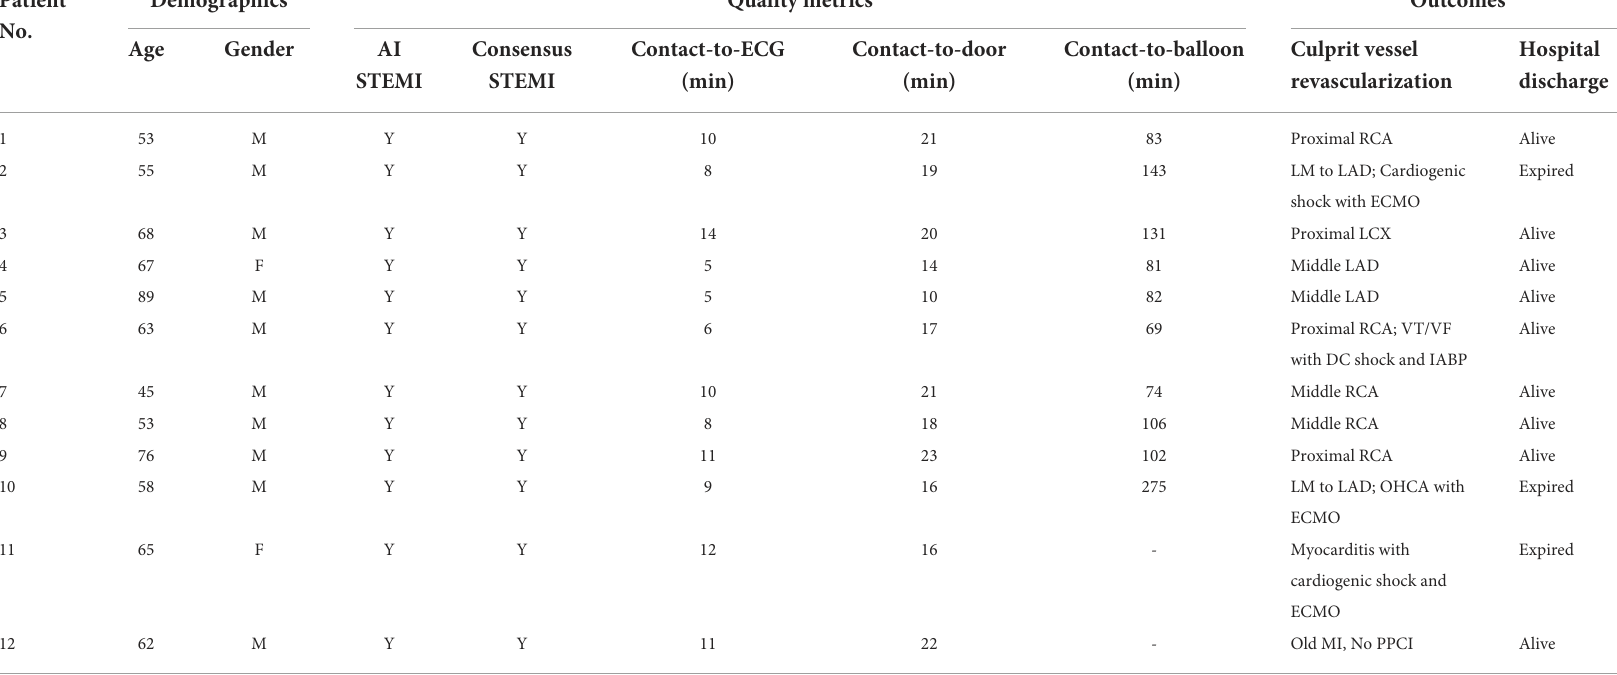
TABLE 1 Consistent labeling of ST-elevation myocardial infarction by AI and ground truth committee (12 cases).